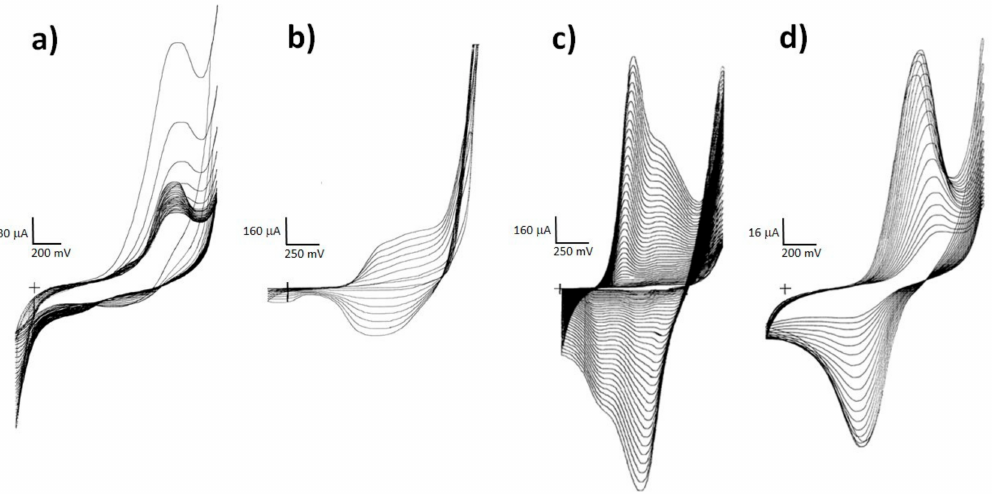
Figure 1. Cyclic voltammograms of PNR on Pt ( a ) and of the step-by-step preparation of a three-layer electrode system PTh-PANI-PNR composed of PTh on Pt ( b ); PANI on PTh ( c ) and PNR on PTh-PANI bilayer ( d ). (The “+” corresponds to the crossing of the x and y-axis in